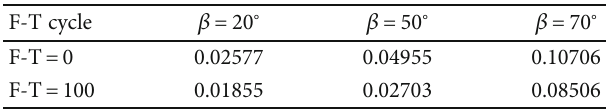
Table 5: Fracture degree of the rock bridge area for samples with di ff erent approach